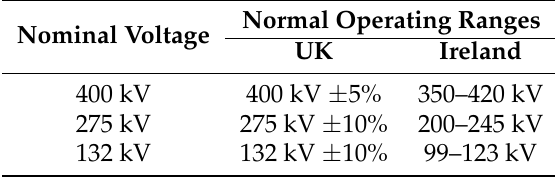
Table 2. Allowed voltage variation ranges for different voltage levels in the UK [147] and Ireland